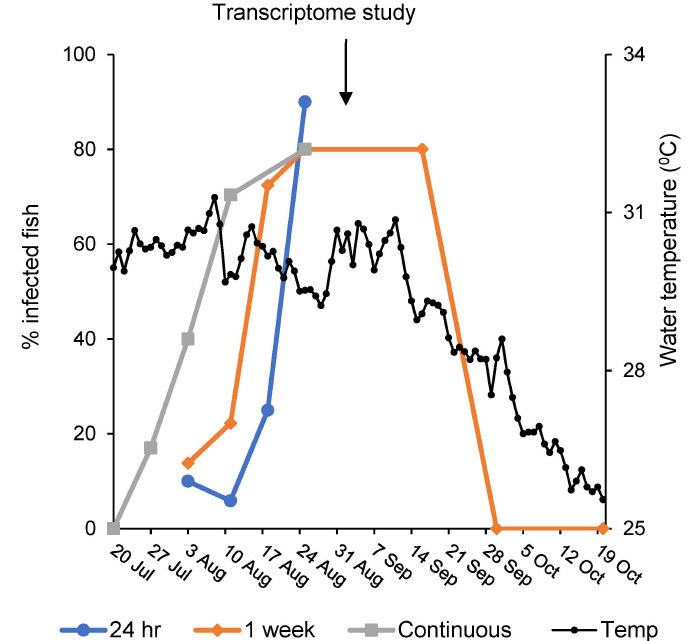
Figure 2. Infectious season of the pond water through 2020. Percentages of infected fish following a continuous exposure (grey line) or limited exposures of 24 h (blue line) or one week (orange line)